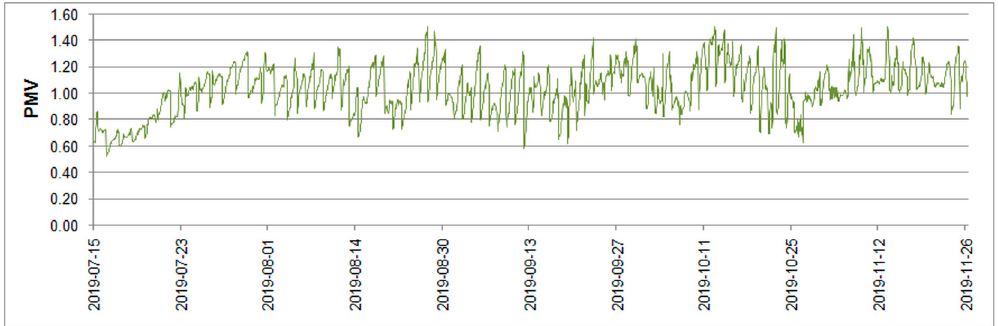
Figure 21. PMV index.